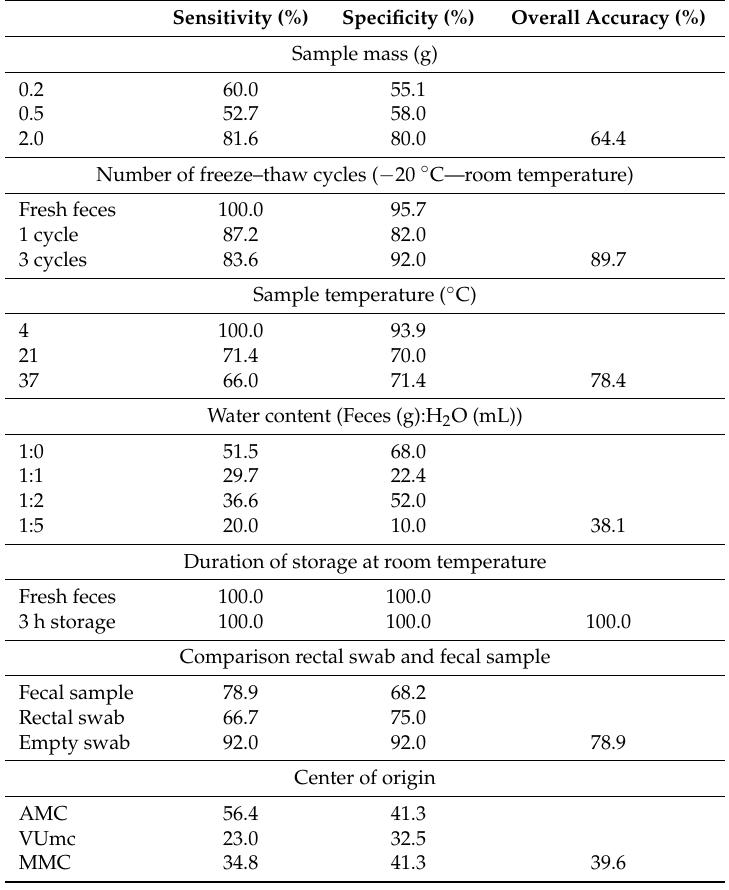
Table 2. Performance characteristics with corresponding sensitivity, specificity and accuracy values of fecal VOC-analysis for each variable of interest were obtained after internal